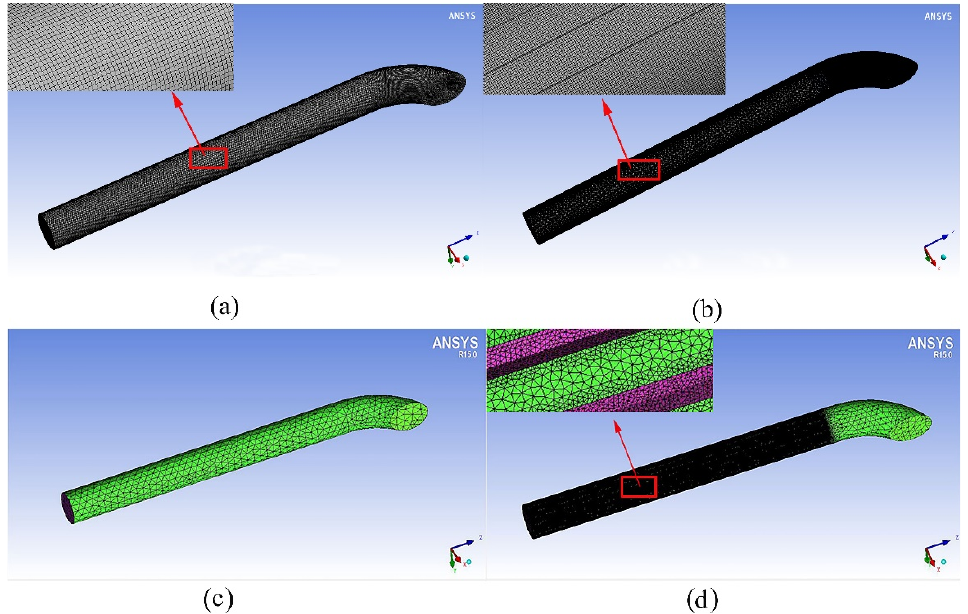
Figure 3. Air cavity grid of exhaust tailpipe: ( a ) prototype, ( b ) bionic exhaust pipe used for aeroa- coustics, ( c ) prototype used for transmission loss, ( d ) bionic exhaust pipe used for transmission loss.